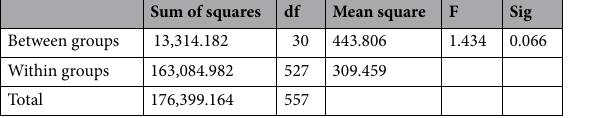
Table 4. One-way ANOVA for Titli CP.